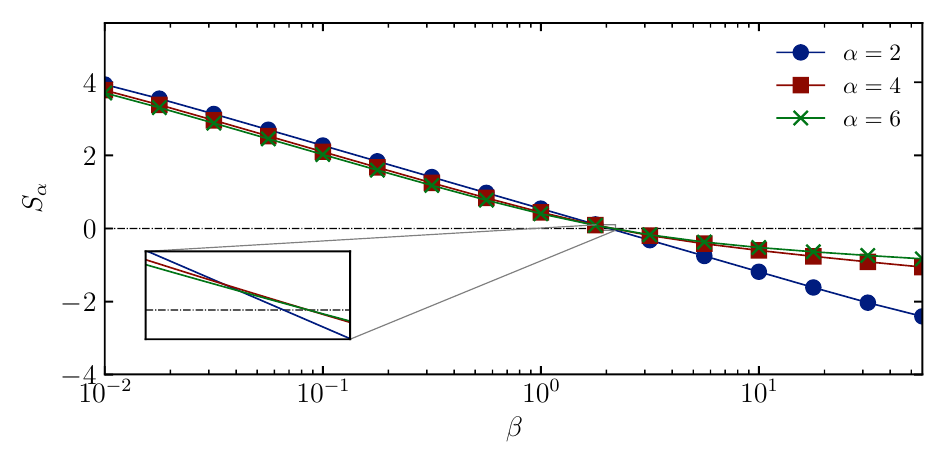
Figure 4: Entropies S α for increasing β for the quartic potential. Parameters are = 0 at β ≈ the same as in Fig. 2, such that S 2